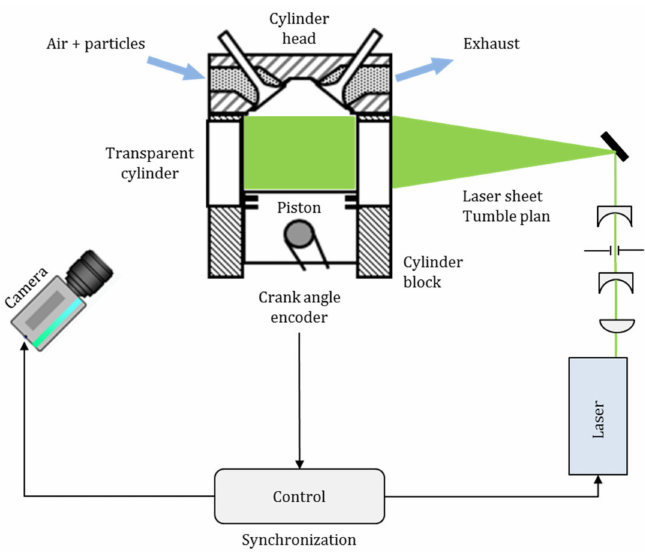
Figure 4. PIV measuring